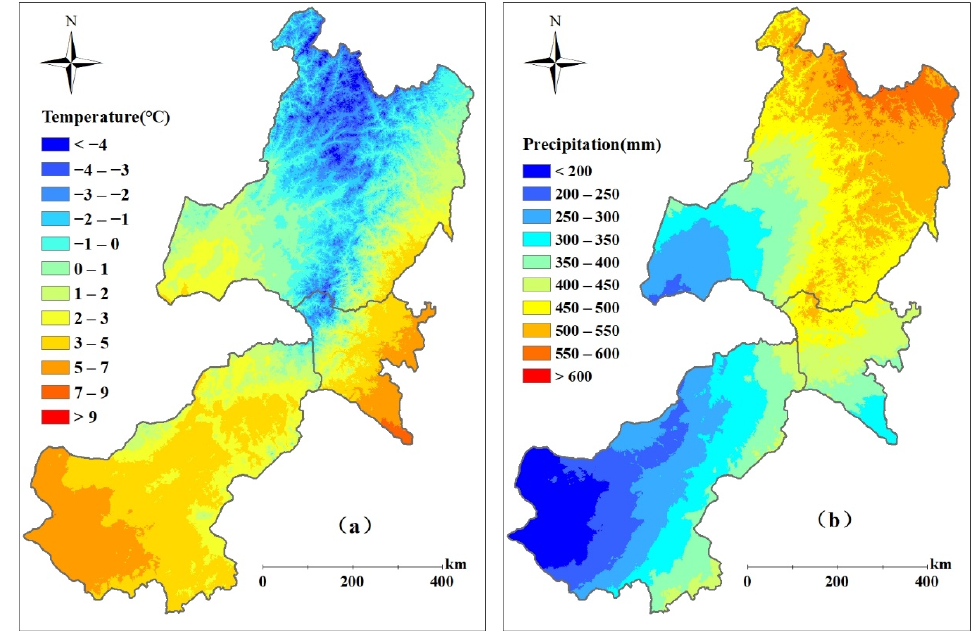
Figure 2. Spatial distribution of annually averaged temperature ( a ) and precipitation ( b ) during 2000–2017 in eastern Inner Mongolia.